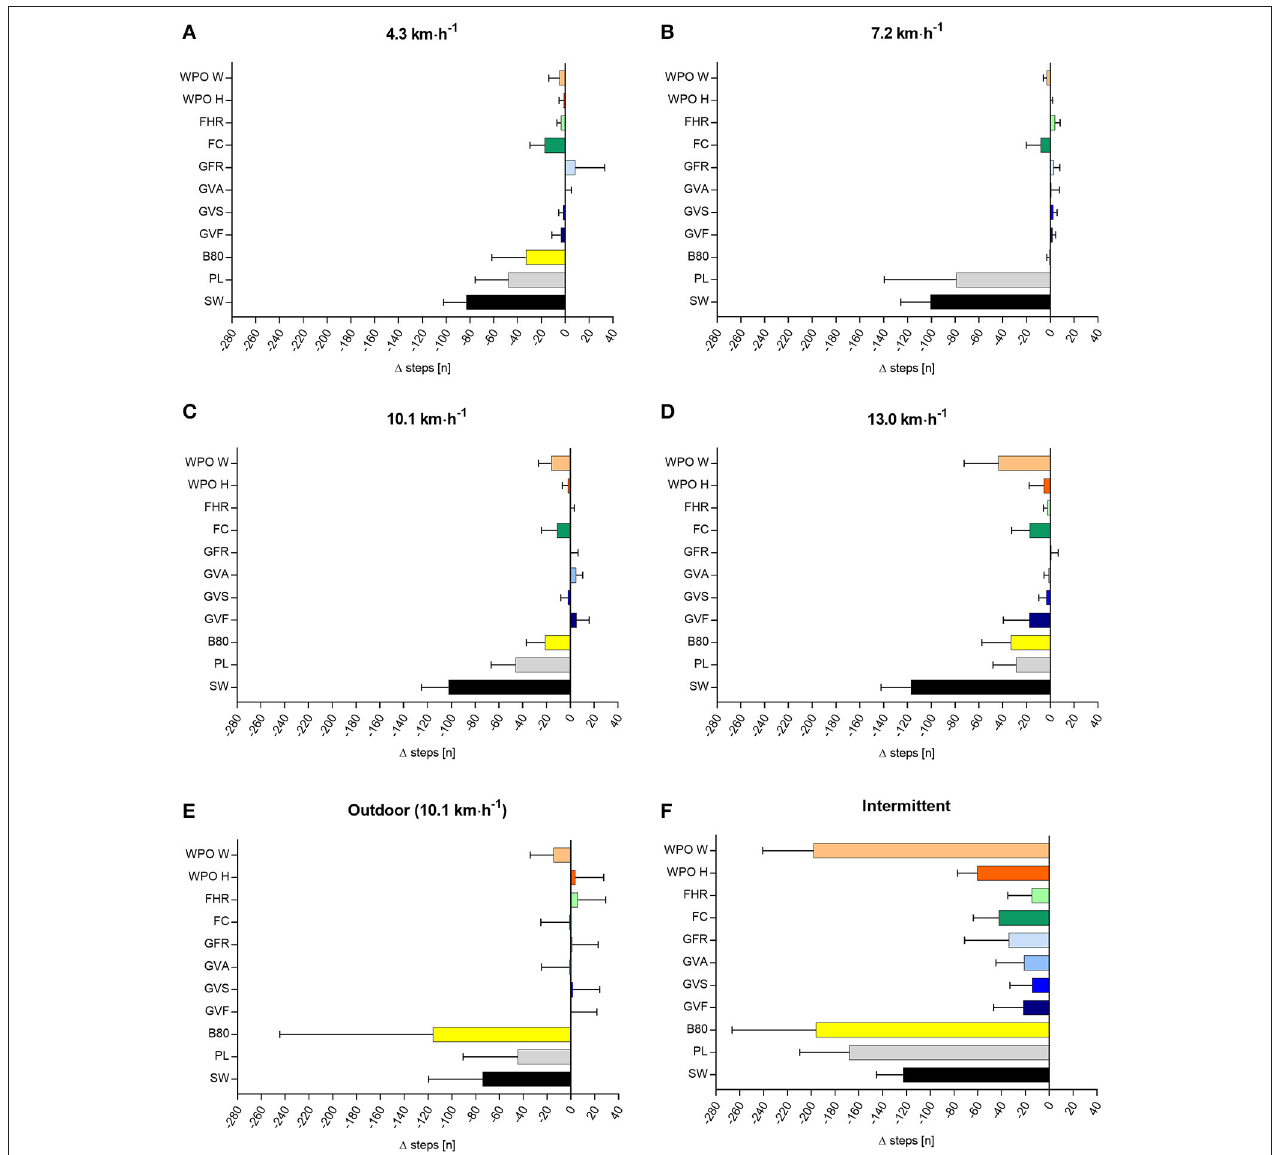
FIGURE 2 | Difference in step count (n) between criterion measure and the eleven activity trackers at different running velocities (A–F) , data are shown as mean ± 95% CI. Mean number of steps ( SD) measured by the criterion measure: 4.3 km h − 1 538 29; 7.2 km h − 1 785 38; 10.1 km h − 1 822 51; 13.0 ± · = ± · = ± · = ± km h − 1 863 56; intermittent 1,231 127; outdoor 2,456 145 steps. SW, Bodymedia Sensewear; PL, Polar Loop; B80, Beurer AS80; GVF, Garmin Vivofit; · = ± = ± = ± GVS, Garmin Vivosmart; GVA, Garmin Vivoactive; GFR, Garmin Forerunner 920XT; FC, Fitbit Charge; FHR, Fitbit Charge HR; WPO H, Withings Pulse O x Hip; WPO W, Withings Pulse O x